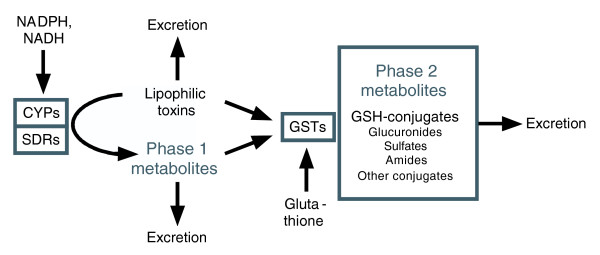
Cellular detoxification (drug metabolism). This process entails two phases: phase 1 (functionalization reactions), and phase 2 (conjugative reactions), which are carried out by several large and diverse gene families, including the CYPs, SDRs and GSTs.